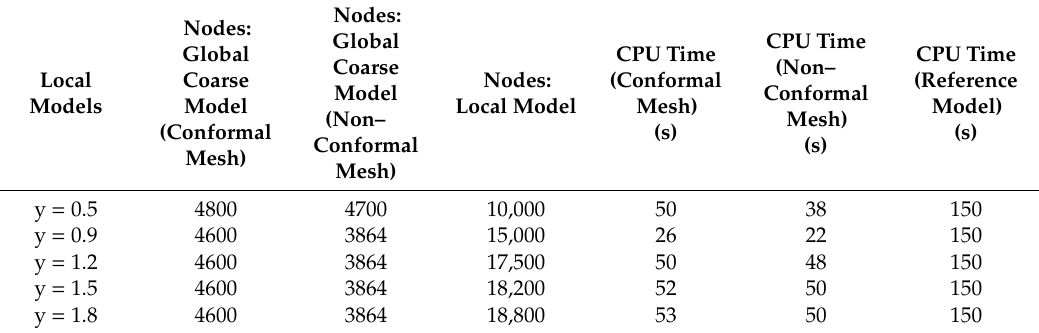
Table 11. Computation time—Three–dimensional Global / Local